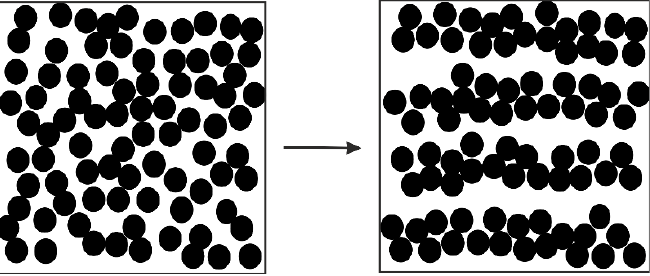
Figure 21. Self-assembling in high concentrated dispersions in the form of layered structure.